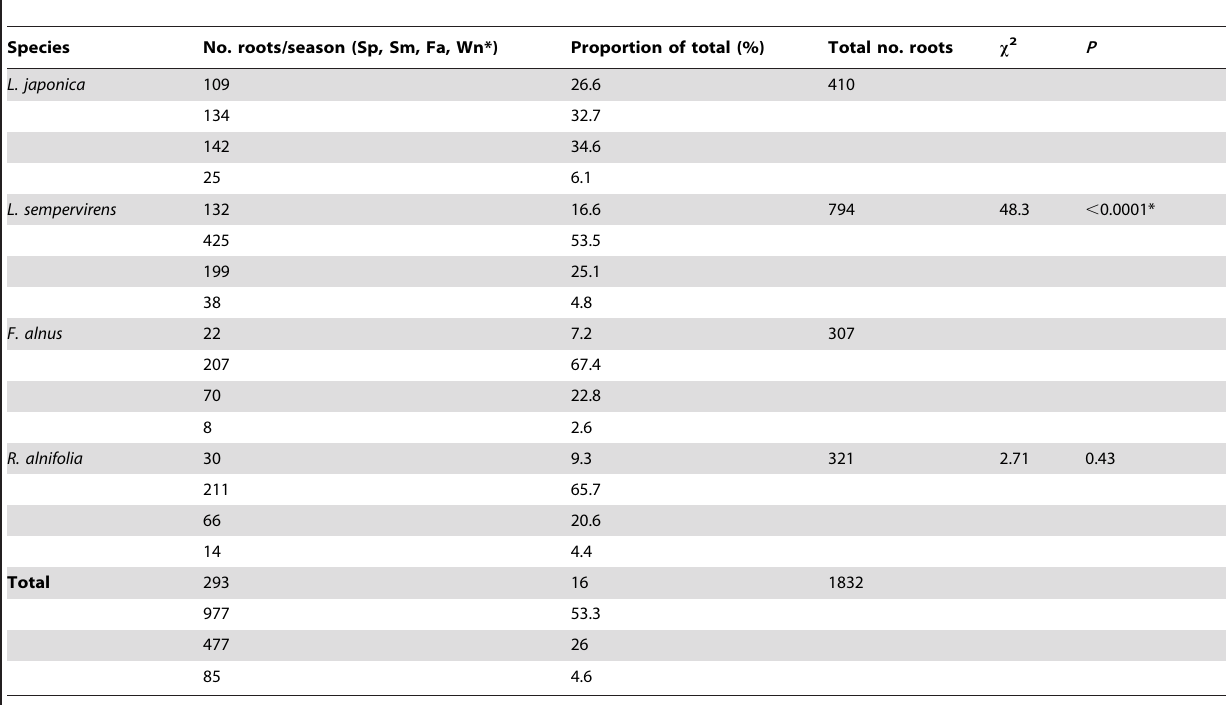
Table 1. Resutls of Chi-square test for differences in total first and second order fine root production between congeneric pairs of Lonicera and Rhamnaceae.